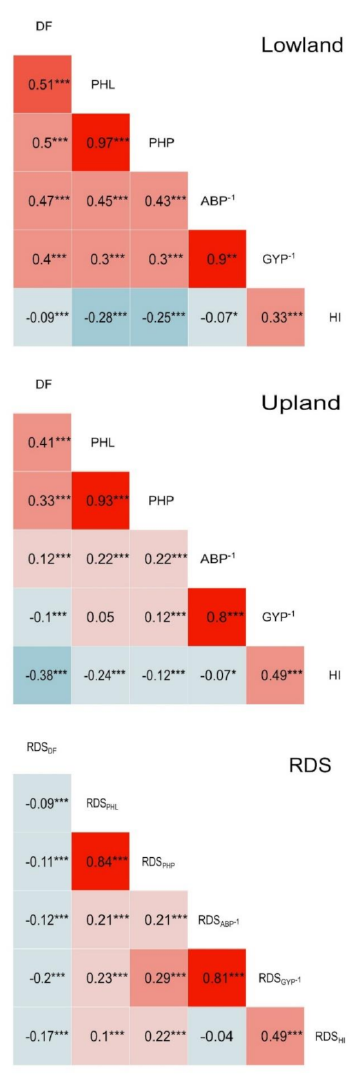
Figure 3. The relationship among days to flowering (DF), plant height to leaf (PHL; cm), plant height to panicle (PHP; cm), aboveground biomass plant − 1 (ABP − 1 ; g), grain yield plant − 1 (GYP − 1 ; g) and harvest index (HI) under lowland condition, upland condition and respective relative drought stress susceptibility ( RDS ) index. Note: * p < 0.05. ** p < 0.01. *** p < 0.001. Drought resistance grade (DRG) was computed from RDS-I from the mean of DRG 1 being − 28.92, followed by the means of DRGs 1–3 and 3 that were − 18.36 and − 8.81 indi- vidually (Table 7). Each DRG was distinct from each other whether they were compared by concerning means or discrete trait values of RDS-I. Tables S4 and S5 indicated that drought resistance of the majority of germplasms (73.79%) from the designated 1118 genotypes was somewhat weak, with DRG scores of 7 (weak), 5–7 (relatively weak) and 7–9 (weaker) corresponding to 29.34%, 22.36% and 22.09% of the population proportion under